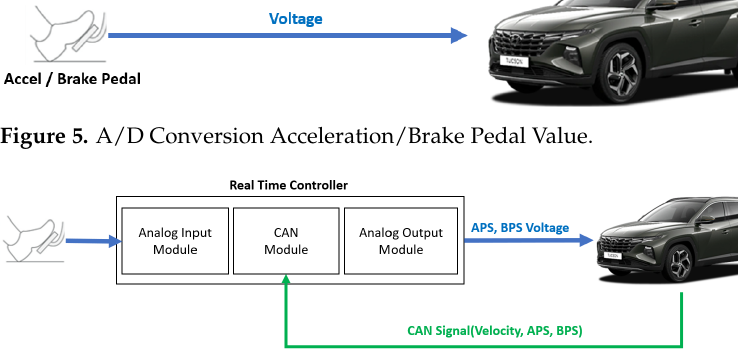
Figure 6. Vehicle Control by the Proposed